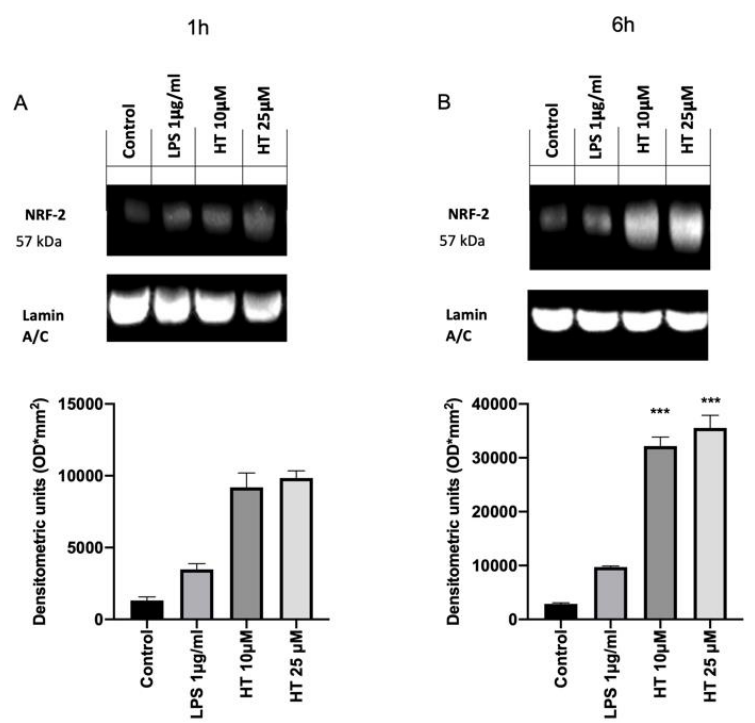
Figure 4. ( A ) E ff ect of HT on NRF2 expression: western blot analysis of NRF2 1 h after LPS 1 µ g / mL stimulation and 10- µ M and 25- µ M HT treatment; ( B ) western blot analysis of NRF2 6 h after LPS 1 µ g / mL stimulation and 10- µ M and 25- µ M HT treatment. Data representative of at least three experiments, means ± SEM; ° p < 0.05 vs. control; * p < 0.05 vs. LPS; ** p < 0.01 vs. LPS; *** p < 0.001 vs.